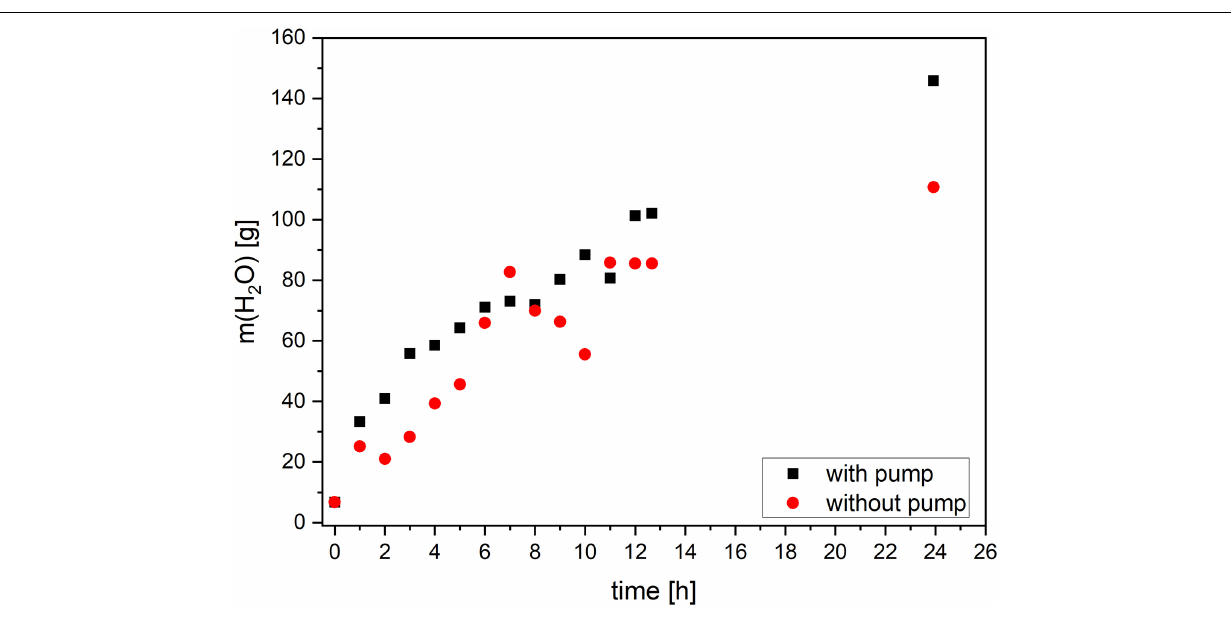
FIGURE 7 | The effect of pumping on water content in acetone as a function of the process time within a system with and without